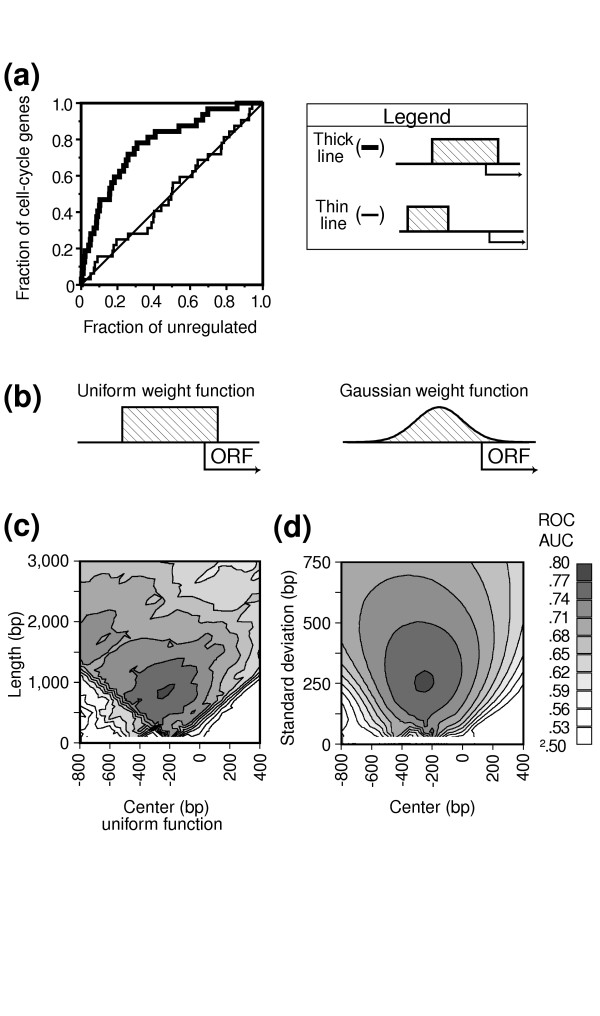
Alternative definitions of the regulatory region and their effect on the prediction of gene regulation. (a) Receiver operating characteristic (ROC) curves showing how CLB2 cluster genes rank compared to all other genes using the forkhead probability matrix and two different definitions of the regulatory region. ROC curves plot the fraction of true positives that meet a threshold value (here, a given GOMER score) against the fraction of false positives that meet that same threshold. The thick line plots a ROC curve for a regulatory region defined as the sequence between 650 base pairs (bp) 5' to the ORF and 150 bp 3' to the start of the ORF; the thin line plots a ROC curve for a regulatory region defined as the sequence between 1,000 bp and 500 bp 5' to the ORF. The latter definition of the regulatory region has no predictive value as reflected in the nearly diagonal ROC curve (area under the ROC curve (ROC AUC) of approximately 0.5). (b) Schematics of a conventional uniform weight function and a Gaussian weight function. (c) Comparison of the uniform weight function and (d) the Gaussian weight function for several hundred combinations of parameter values. The contoured areas are shaded according to ROC AUC value as indicated on the scale. To facilitate comparison, the regulatory regions defined by the uniform weight function are plotted in terms of the center of the region, analogous to the center of the Gaussian distribution. Center values are expressed as distance from the open reading frame (ORF); negative values are 5' to the ORF start. For the Gaussian function, weights below 1/1,000th the maximum value are rounded down to 0.